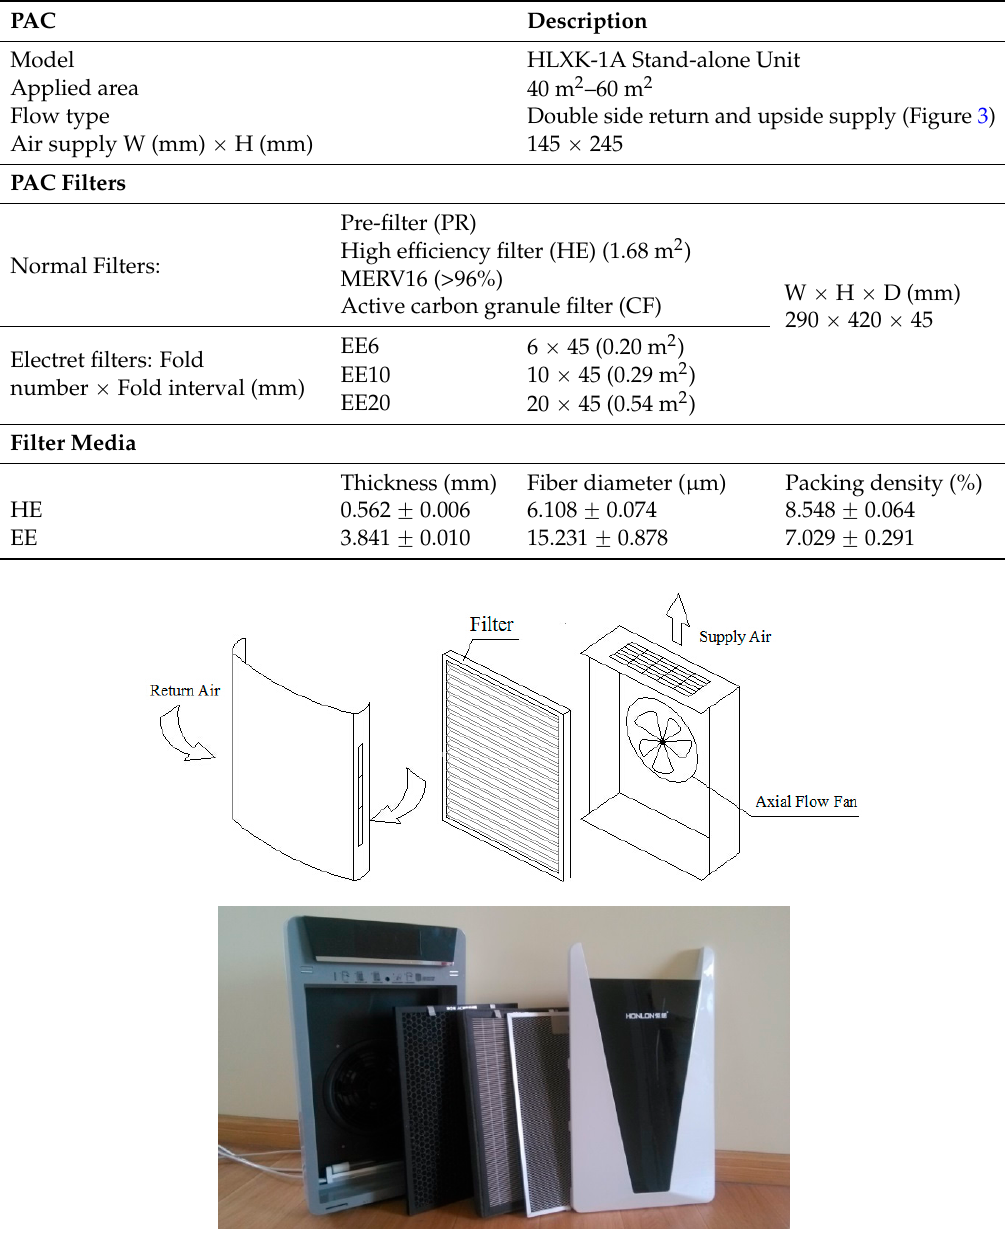
Table 1. Descriptions of the portable air cleaner, filters and filter media tested in this study. All filters are designed with sealing strips to prevent bypass, as shown in Figure 3. The filter changes in the PAC do not change the airflow geometry of the unit.